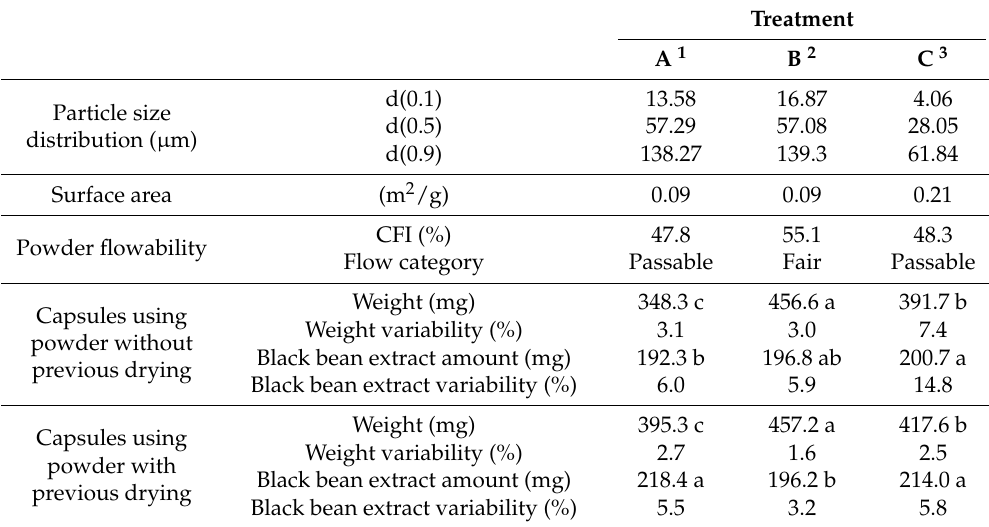
1 : Black bean capsule formulation using 50.0% of maltodextrin, 49.1% of microcrystalline cellulose 50 and 0.9% of magnesium stearate as excipients; 2 : Black bean capsule formulation using 25.0% of maltodextrin, 24.1% of